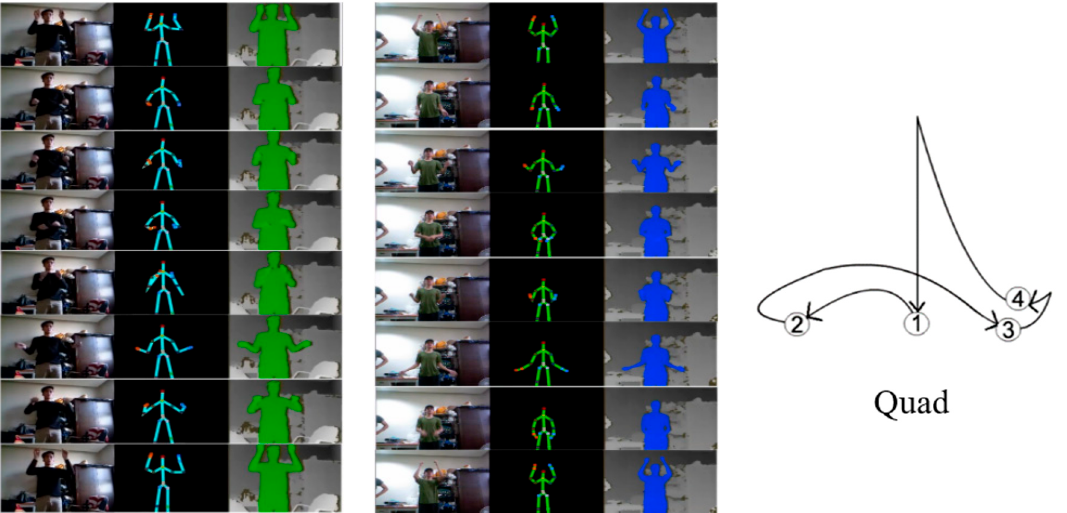
Figure 16. Screenshots of a single musical conducting gesture (quad) being made while facing the camera, including the 2D video, a skeleton model of the musical conductor, and the depth video. Table 2. Accuracy of musical conducting gesture recognition.